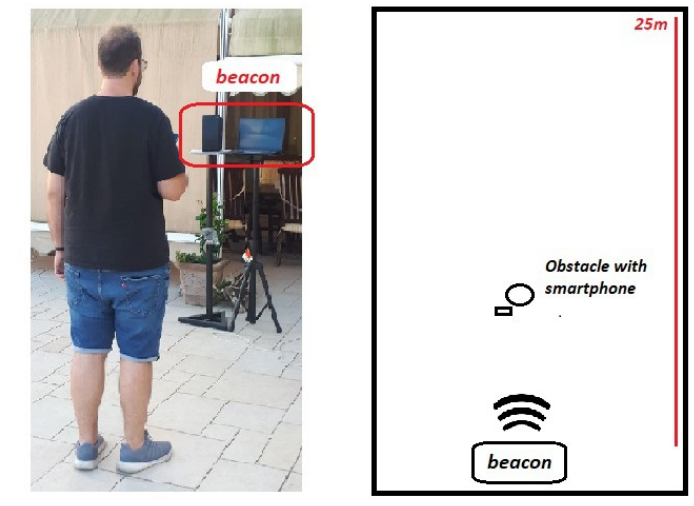
Figure 6. Set-up of the experimental testbed and test